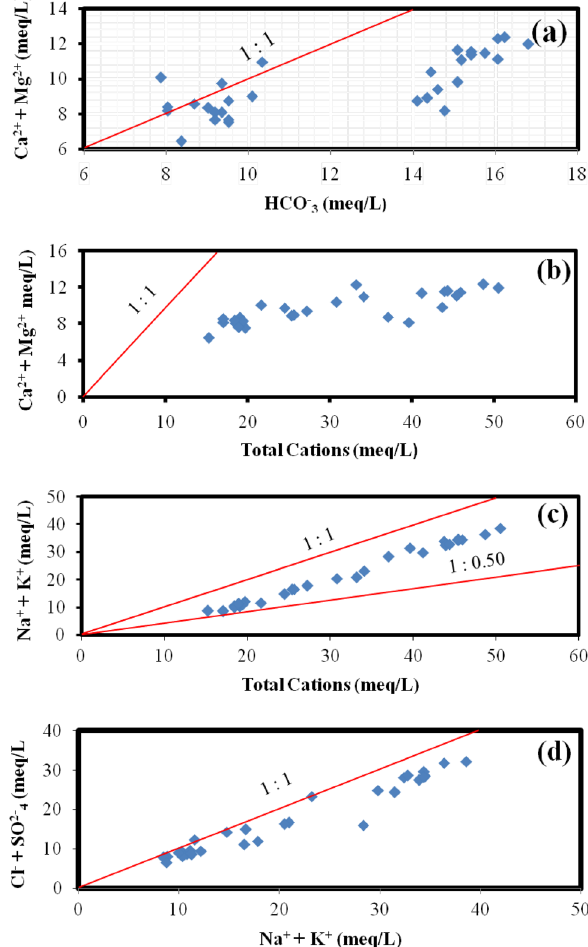
Fig. 5 Relation between a HCO − 3 and Ca 2+ + Mg 2+ , b total cations and Ca 2+ + Mg 2+ , c total cations and Na + + K + and d Na + + K + and SO 2 − Cl − +